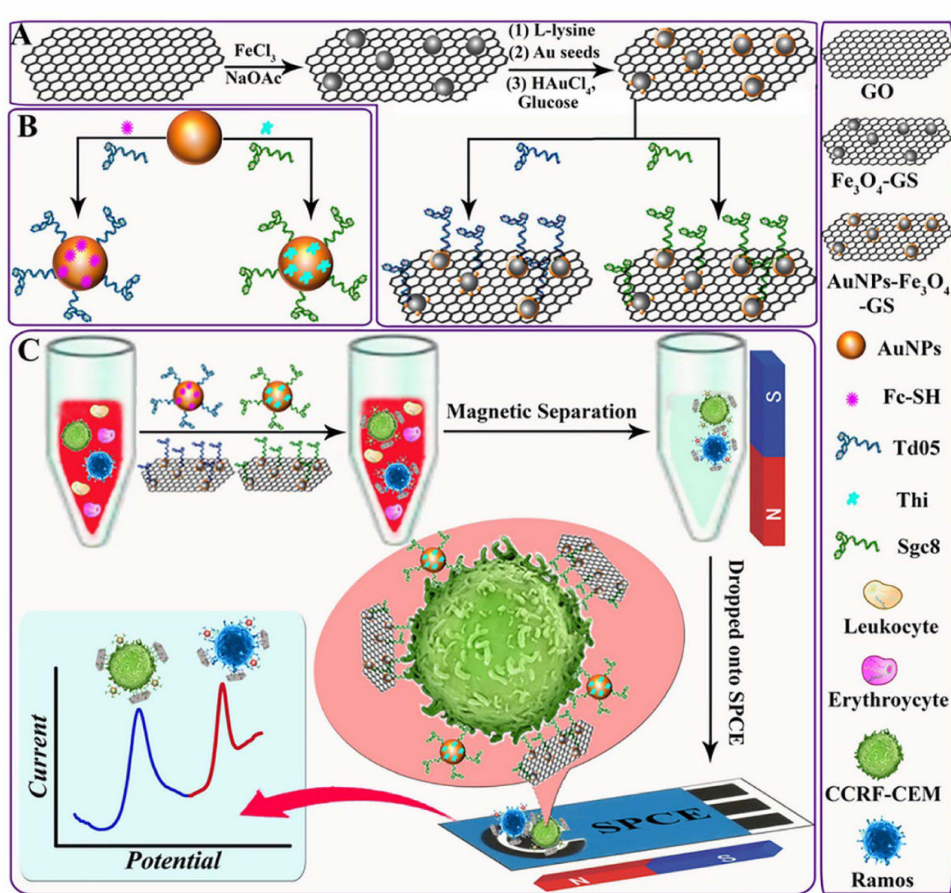
Figure 5. Schematic representation of the synthesis of ( A ) the aptamer-carrying “AuNPs-Fe 3 O 4 - graphene sheet” based bionanocomposite capture probes and ( B ) the aptamer/electroactive substances-modified AuNPs Signaling Probes and ( C ) detection protocol of the developed biosensor containing capture, magnetic separation, signal amplification and target sensing steps. Reprinted with permission from Ref. [89]. Copyright 2019, American Chemical